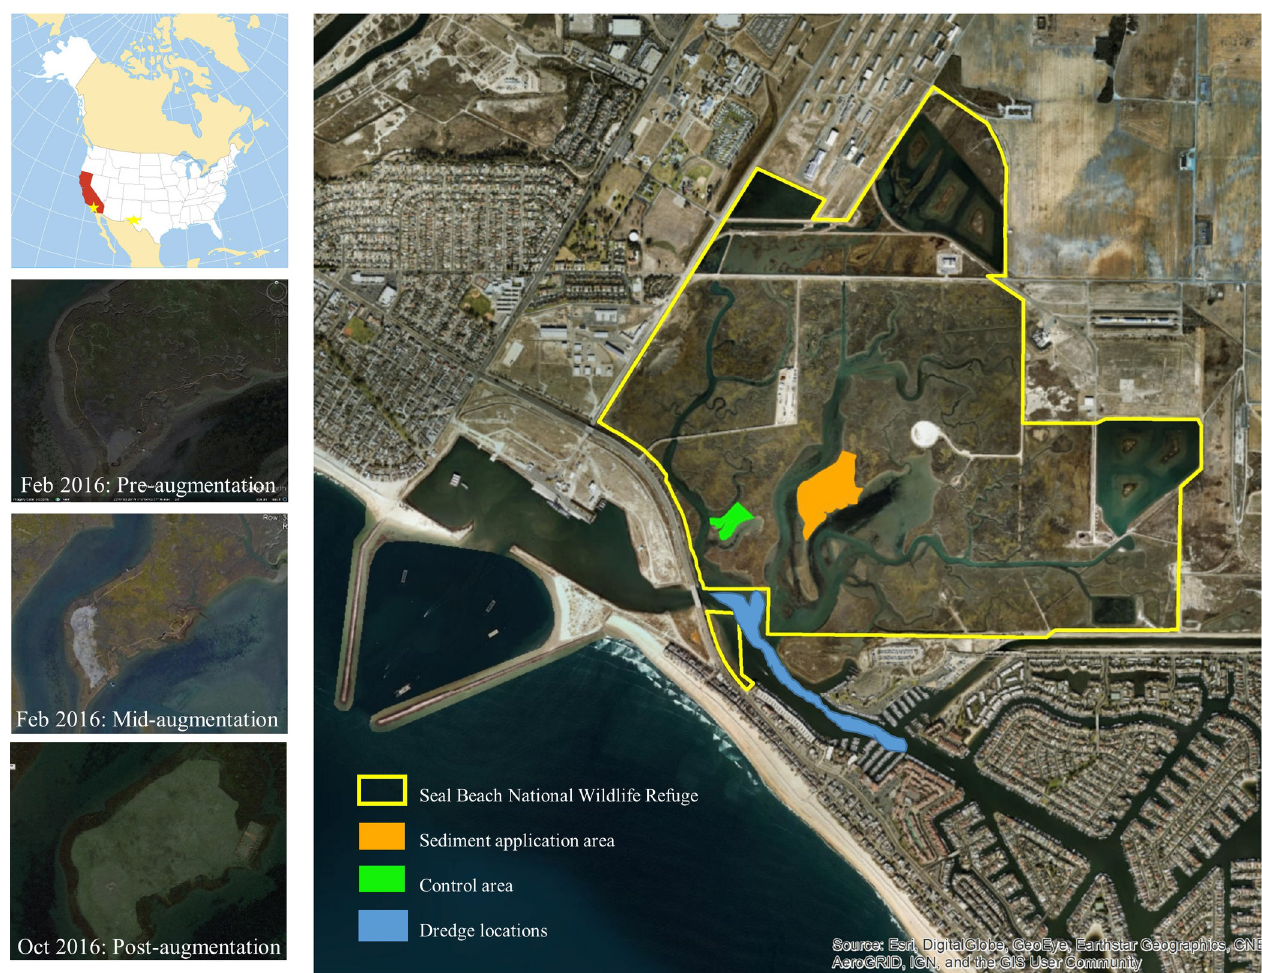
Fig 1. Control and sediment application sites within the Seal Beach National Wildlife Refuge shown in relation to the dredge locations in neighboring Anaheim Bay. Aerial images show the addition of sediment through time from early February 2016 (pre-sediment application) through end of February 2016 (midway through sediment application) until October 2016 (post-sediment application). Image data: Google, Maxar